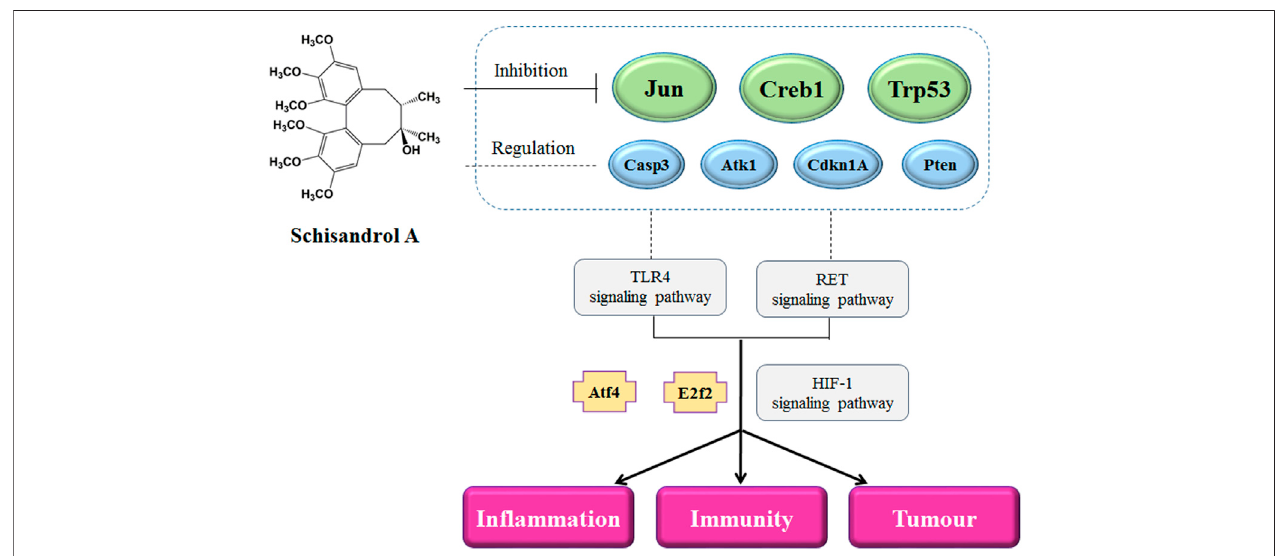
FIGURE 8 | Potential molecular mechanism of the regulation of Schisandrol A on the immune